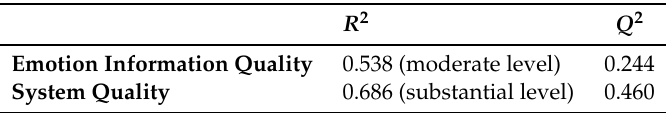
Table 5. Explanatory power ( R 2 ) and predictive relevance ( Q 2